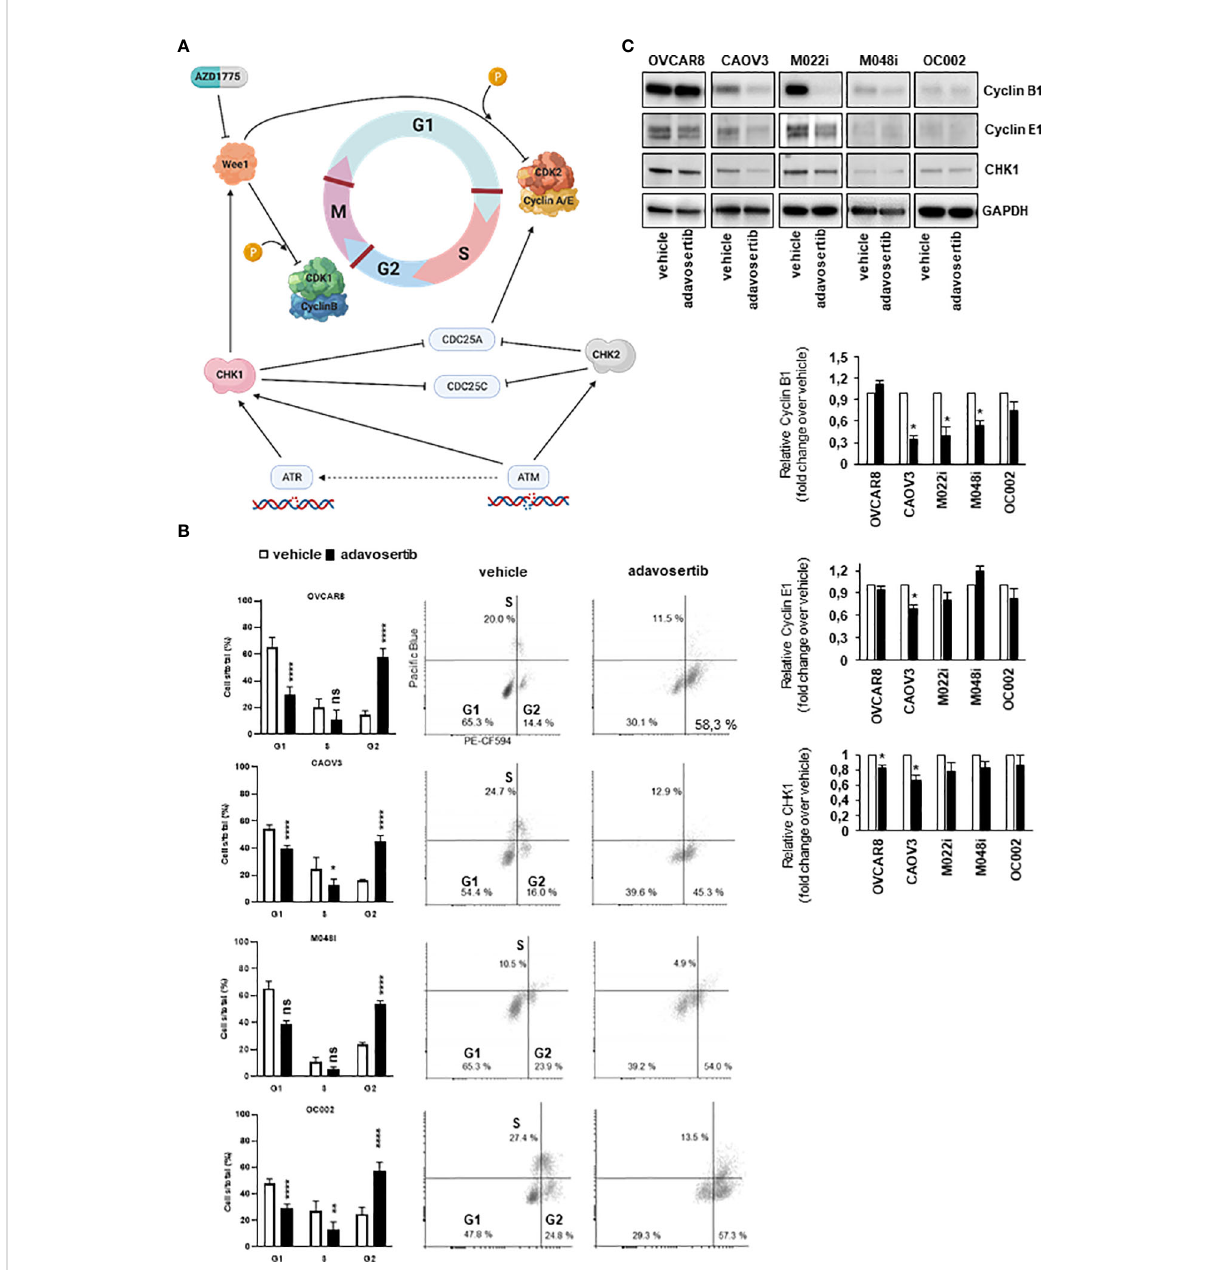
FIGURE 3 Effect of adavosertib on the cell cycle. (A) Illustration of cell-cycle checkpoints involved in DNA-damage response (DDR) pathways, including the role of Wee1. In HGSOC cells, the G1/S checkpoint is dysfunctional due to p53 mutation, while the G2/M checkpoint remains functional in DNA-damage repair. Inhibition of Wee1 by adavosertib (AZD1775) disables the G2/M checkpoint, thereby enabling a cell with damaged DNA to enter mitosis. Created with BioRender.com. (B) HGSOC cells were labeled with 5-ethynyl-2-deoxyuridine (EdU), and cell-cycle phases were monitored with fl ow cytometry. The distribution of cells in the G1, S, and G2/M phases is shown after 72 h of treatment with adavosertib (500 nM) or vehicle. White bars = vehicle and black bars = adavosertib treated (average, ±SD). Dot blots present the distribution of cells with EdU staining. (C) Western blot analysis of cyclin B1, cyclin E1, and Wee1 pathway regulating CHK1 protein in adavosertib- (500 nM) and vehicle- treated cells after 72 (h) The bars show quantitative analysis of cyclin B1, cyclin E1, and CHK1, normalized to GAPDH, using ImageJ software. The values shown are the mean ± SE of three separate experiments. Signi fi cant difference between vehicle and adavosertib treatment was determined by the t -test at ns = p > 0.05, *p ≤ 0.05, **p ≤ 0.01 and ****p ≤